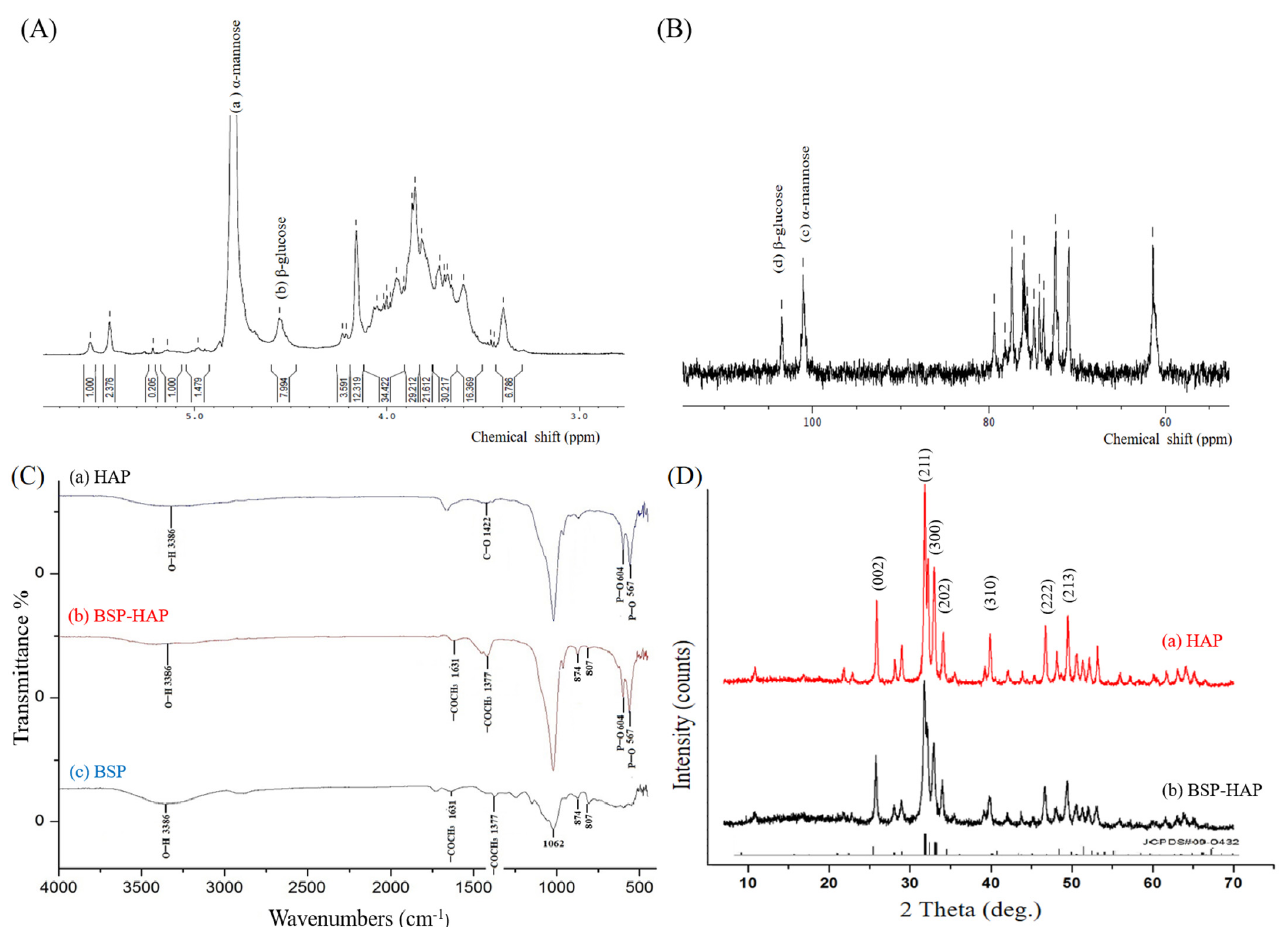
Figure 2. The Molecular structure, functional groups and crystal structure identification of BSP-HAP. ( A ) The 1 H-NMR spectrum, the peaks at 4.8 ppm and 4.5 ppm indicated as (a) and (b) in the structure are the characteristic peaks for α -mannopyranose and β -glucopyranose, respectively. ( B ) The 13 C-NMR spectrum, the signals at 101.1 ppm and 103.5 ppm could be attributed to α -mannopyranose and β -glucopyranose as indicated in (c) and (d) in the structure, respectively. ( C ) FTIR patterns of HAP, BSP-HAP, and BSP. The absorption bands at 567 cm − 1 , 604 cm − 1 , and 3386 cm − 1 were matched to the HAP. Absorption band at 807 cm − 1 , 874 cm − 1 and 1062 cm − 1 were matched to the BSP. The FTIR spectrum presents all the characteristic absorption bands contributed by HAP and BSP. ( D ) X-ray diffraction patterns of HAP and BSP-HAP. All the characteristic peaks were matched to the standard pattern of HAP in No. 09-0432 of JCPD card.